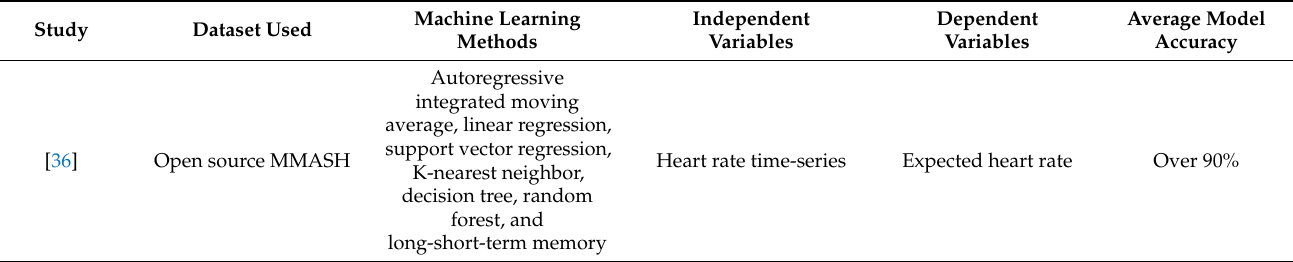
Table 5. Research